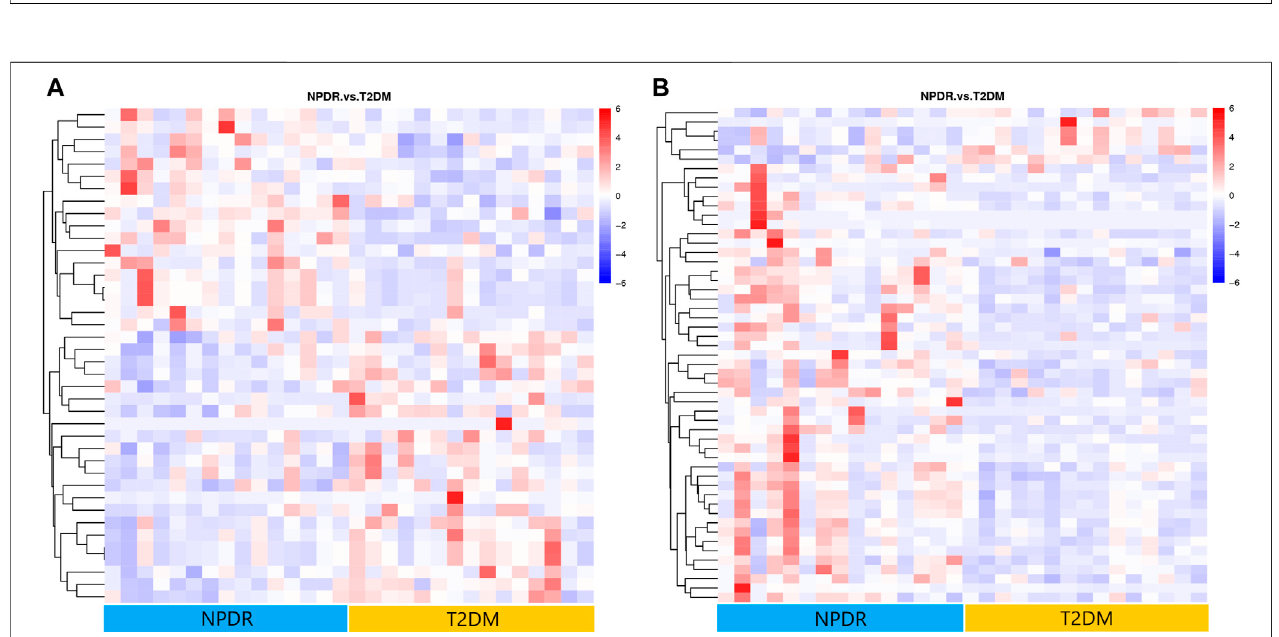
FIGURE2|(A) Positivemode. (B) Negativemode. Hierarchicalclusteringanalysis(HCA)showedthattheidenti fi edmetaboliteswereclearlygroupedintocontrols, T2DM, andPDRpatient clusterswithhighrepeatability,andtheresultingdatawerereliableandlogical.Signi fi cantmetabolicfeatures increased(red)ordecreased(blue) compared with the others group.